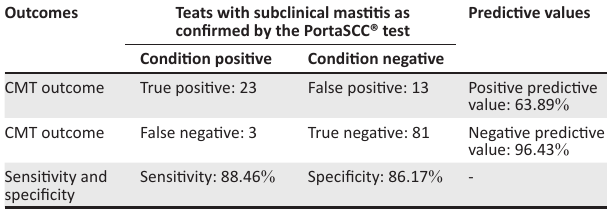
TABLE 2: Cross tabulation of California Mastitis Test and PortaSCC® results.